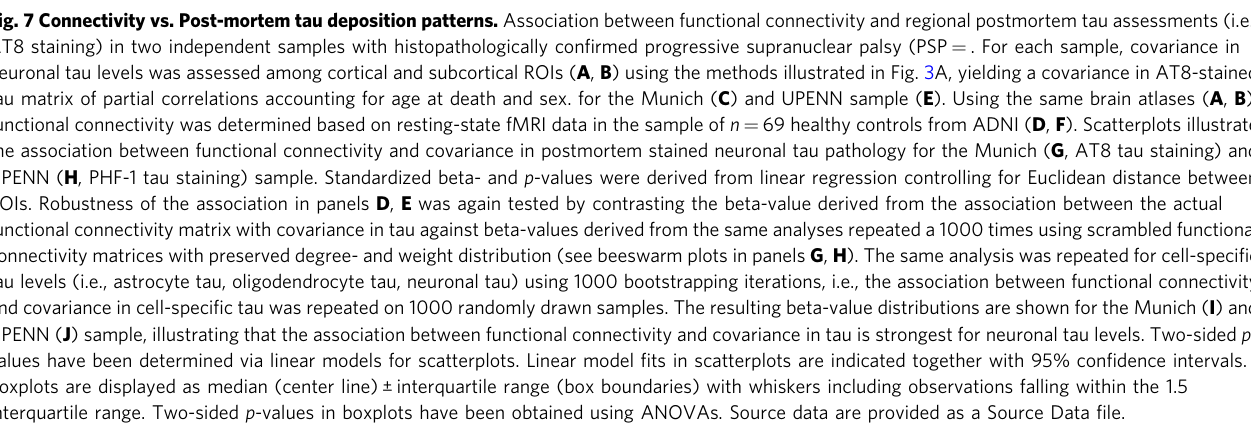
Fig. 7 Connectivity vs. Post-mortem tau deposition patterns. Association between functional connectivity and regional postmortem tau assessments (i.e., AT8 staining) in two independent samples with histopathologically con fi rmed progressive supranuclear palsy (PSP = . For each sample, covariance in neuronal tau levels was assessed among cortical and subcortical ROIs ( A , B ) using the methods illustrated in Fig. 3A, yielding a covariance in AT8-stained tau matrix of partial correlations accounting for age at death and sex. for the Munich ( C ) and UPENN sample ( E ). Using the same brain atlases ( A , B